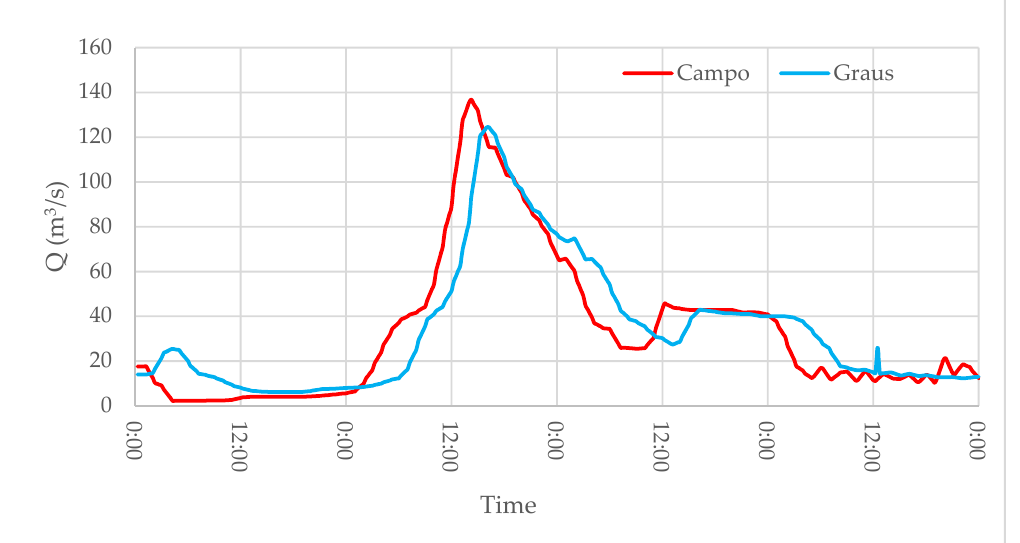
Figure 3. Observed hydrograph at Campo and Graus gauge stations (event C3).